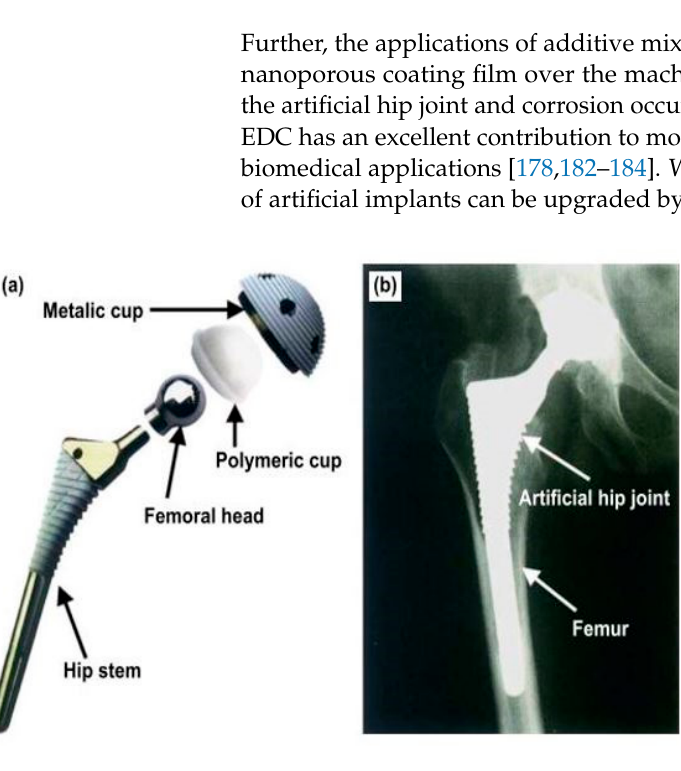
Figure 26. Artificial hip joint: ( a ) structure, ( b ) implanted into human body, and ( c ) corrosion after implantation [180,181].